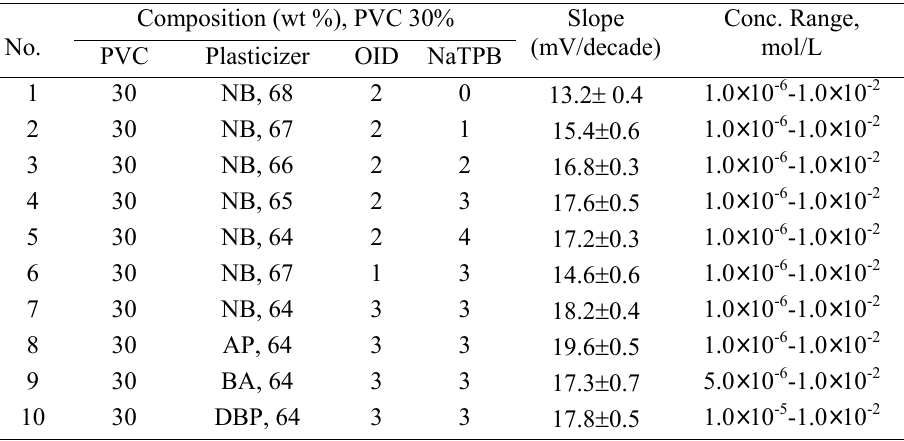
Table 1. Optimization of the membrane